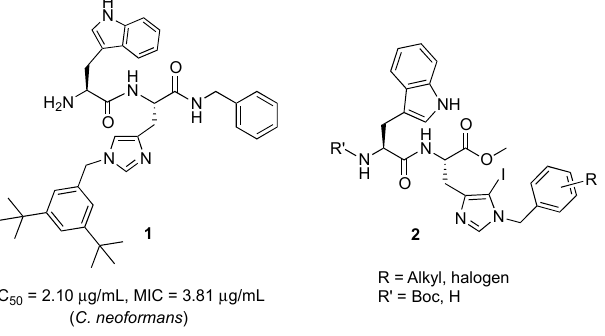
Figure 1. Structures of dipeptides.